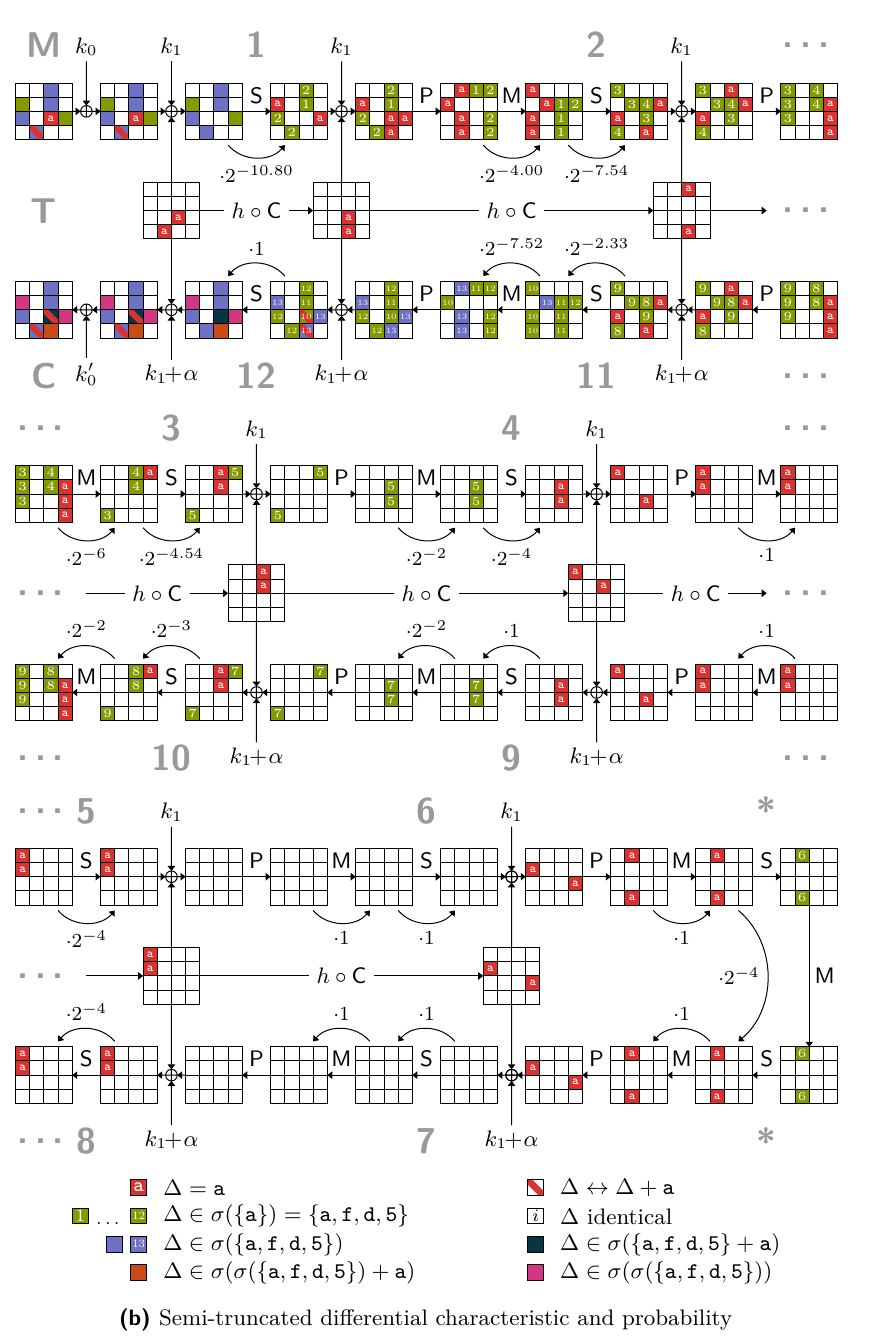
Figure 3: Attack on MANTIS